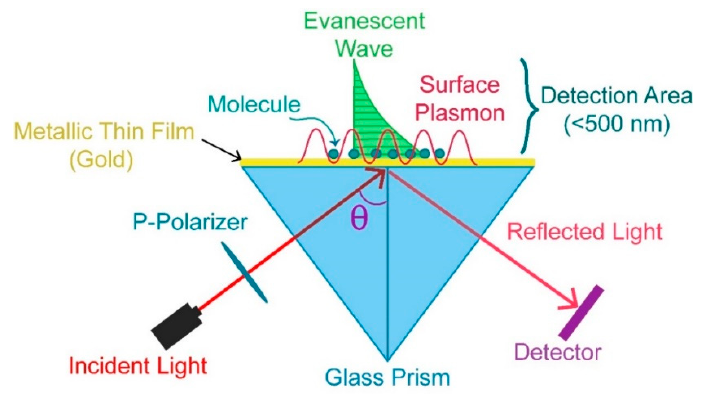
Figure 1. Experimental set-up of surface plasmons (SPs) excitation.